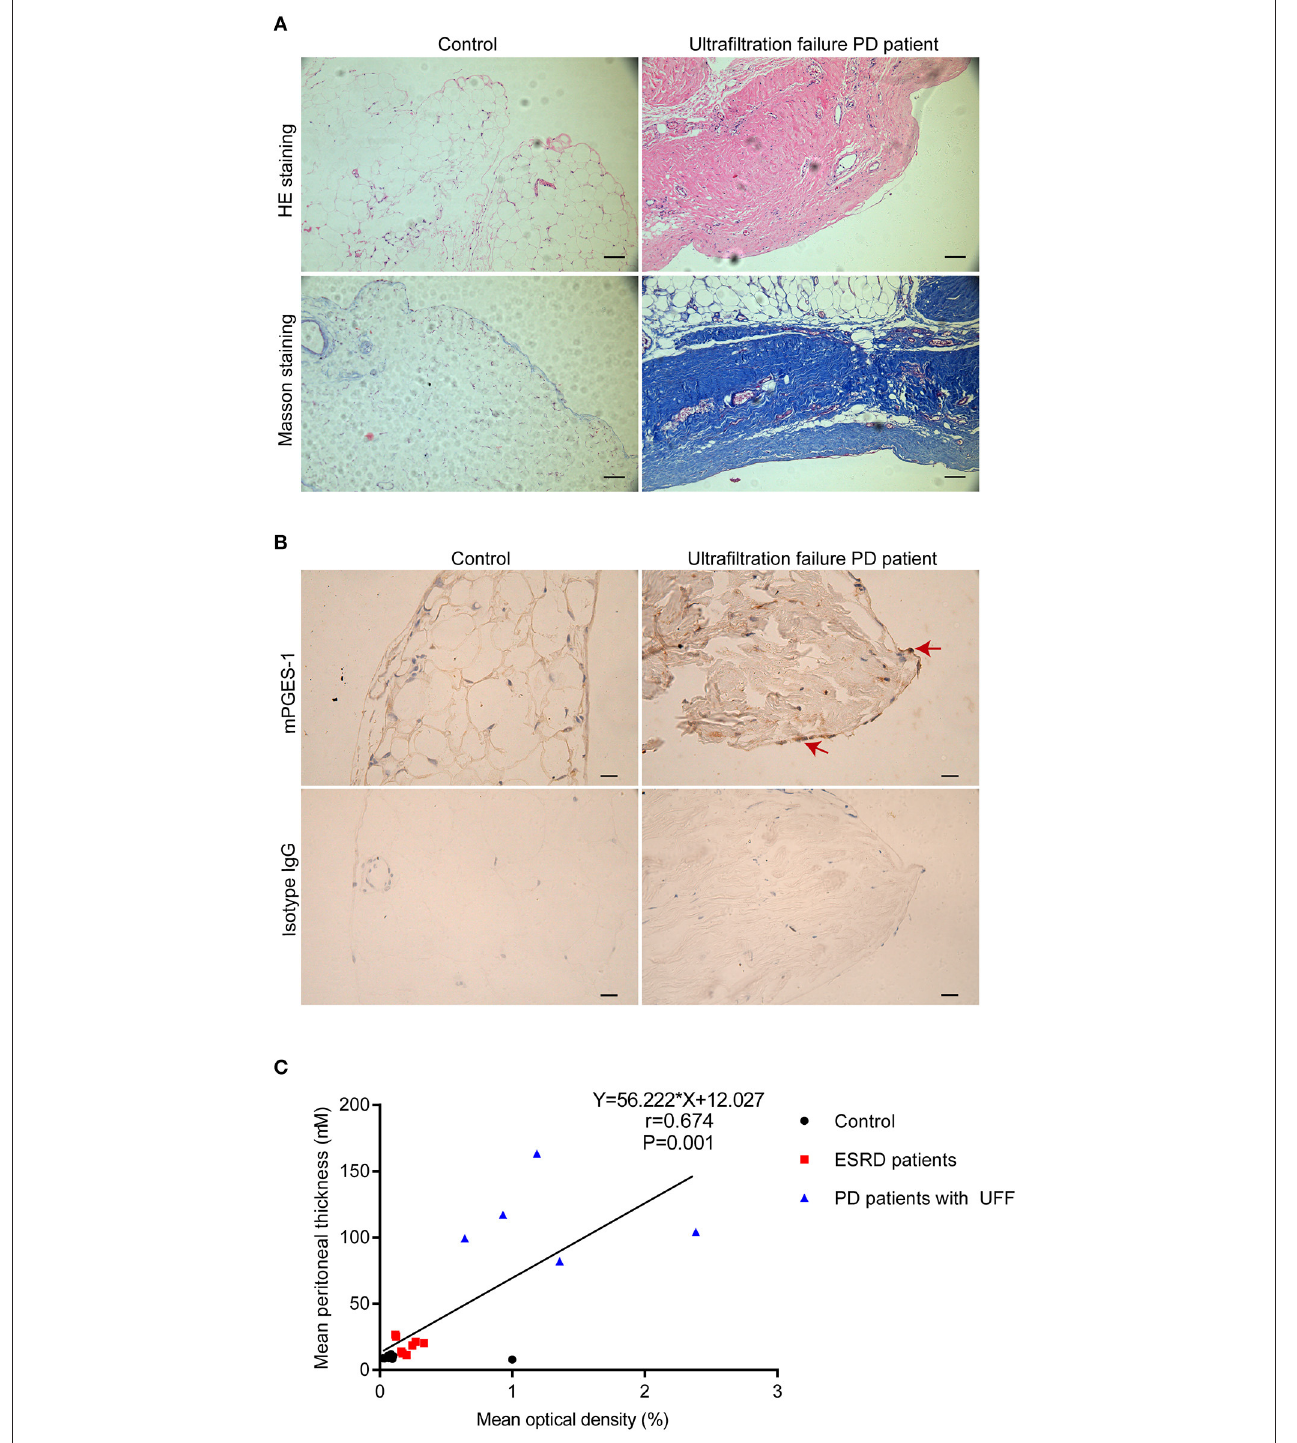
FIGURE 1 | Enhanced expression of mPGES-1 in the peritoneal tissues of PD patients with ultrafiltration failure. (A) Representative HE and Masson staining in peritoneal tissues of inguinal hernia patients with normal renal function and PD patients with UFF. Magnification: 100 × . Scale bar: 100 µ m. (B) Representative image of immunohistochemical staining of mPGES-1 in the peritoneal tissues of inguinal hernia patients with normal renal function and PD patient with UFF. Analysis of mPGES-1 antibody specificity by replacing mPGES-1 antibody with isotype IgG. Magnification: 400 × . Scale bar: 20 µ m. (C) Correlation between the expression of mPGES-1 in peritoneal tissues and the thickness of the peritoneum (Spearman’s rank correlation analysis, n = 21). Symbols of black dot, red square, and blue triangle represented control, ESRD patients, and PD patients with UFF, respectively.